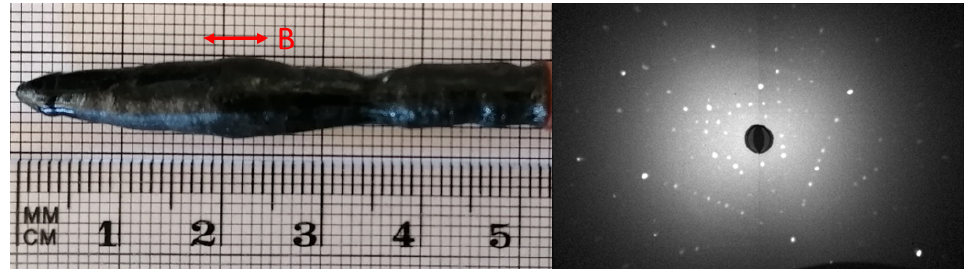
Figure 7. ( left ) As-grown crystal boule of Mn 3 Al 2 Ge 3 O 12 (sample labeled MAGG_C3) obtained, in nitrogen gas atmosphere at a pressure of 1 bar, by melting the feed rod twice using a growth rate of 2–6 mm h − 1 . The initial polycrystalline feed rod (prepared in the same conditions as the MAGG_5 sample) was processed at a growth rate of 20 mm h − 1 . The boule thus obtained was used as feed rod for the final crystal growth, when a growth rate of rate of 2–6 mm h − 1 was employed. ( right ) The Laue backscattering photograph corresponds to the consistent pattern obtained from the region labeled B, 7 mm in